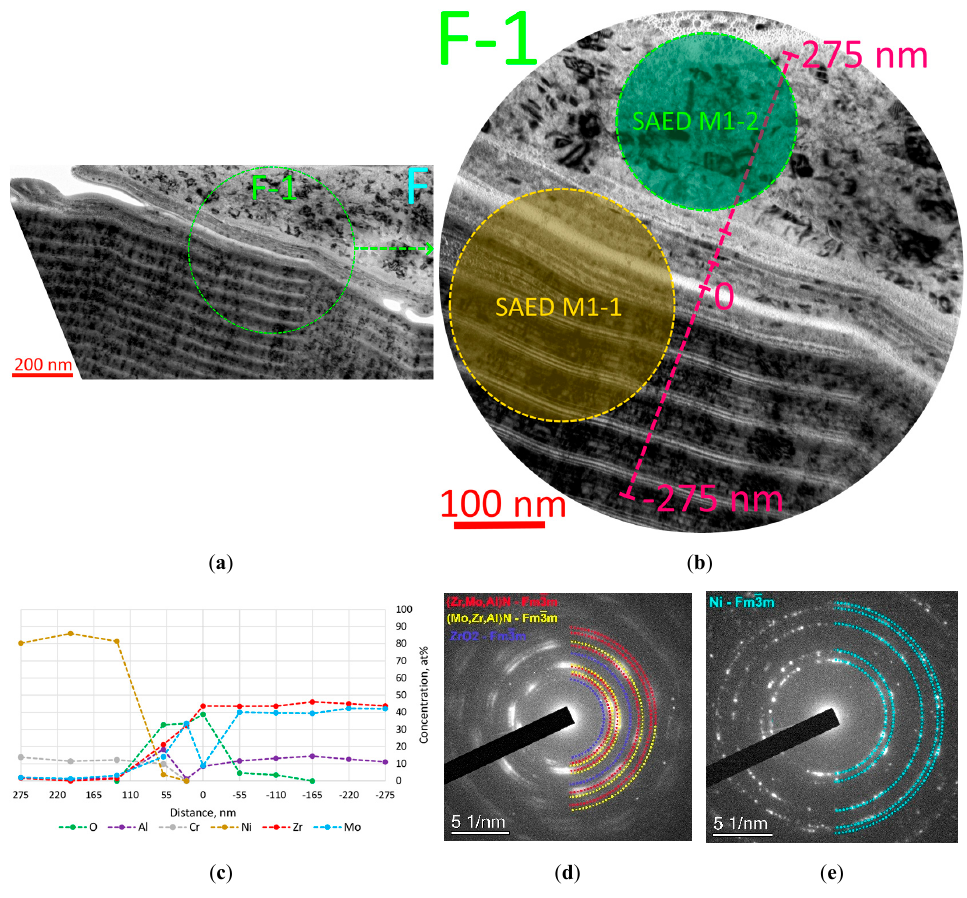
Figure 6. ( a ) General view of Area F under consideration; ( b ) “coating–adherent” interface with indication of the line for study of the elemental composition and areas of SAED; ( c ) results of the study of the elemental composition along the specified line; ( d ) SAED M1-1 from the coating area at the “coating–adherent” interface; ( e ) SAED M1-2 from the area of contact between the adherent and the coating. The localization of area F is shown in Figure 4.